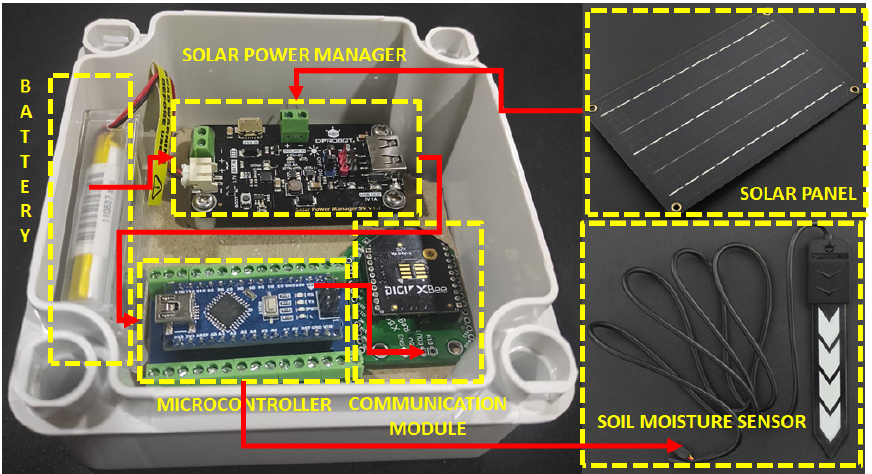
Figure 3. The internal components that make up each of the nodes of the WSN network: power supply (battery, solar panel and its controller), microcontroller, communication system, humidity sensor.